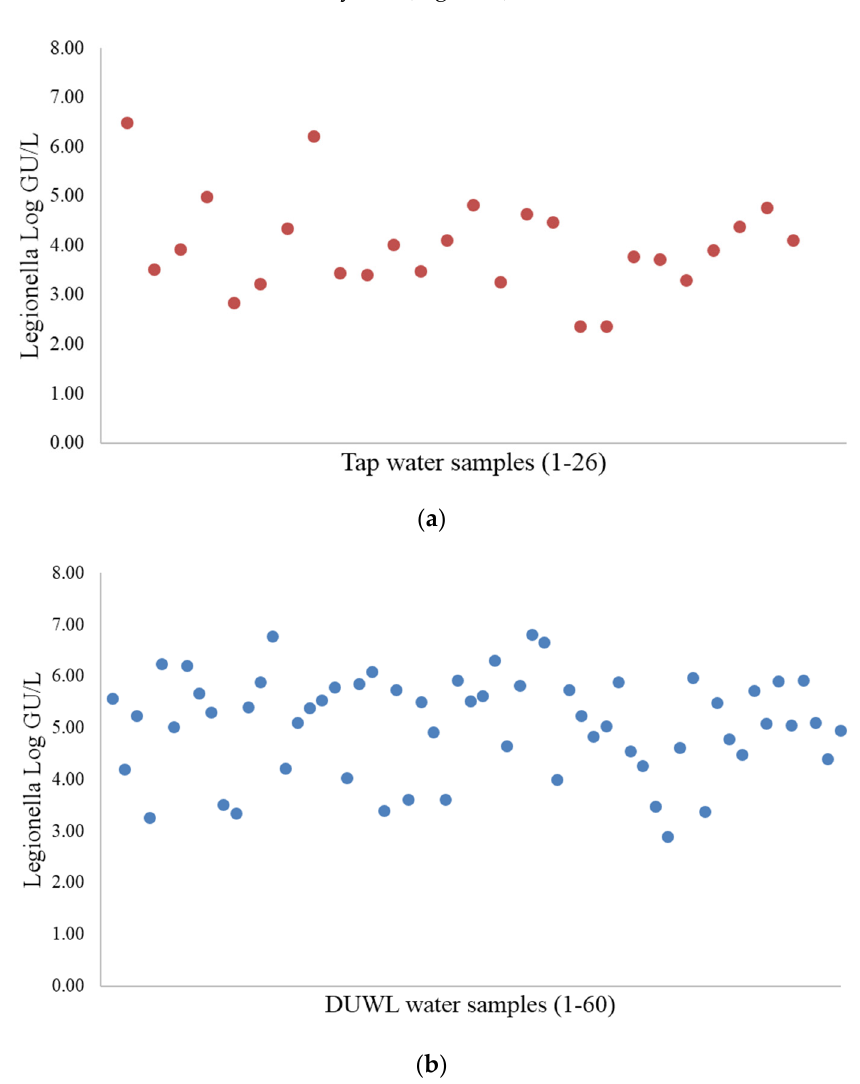
Figure 1. Quantitative results for ( a ) the tap water and ( b ) DUWL samples, as determined using the PMA-qPCR method.